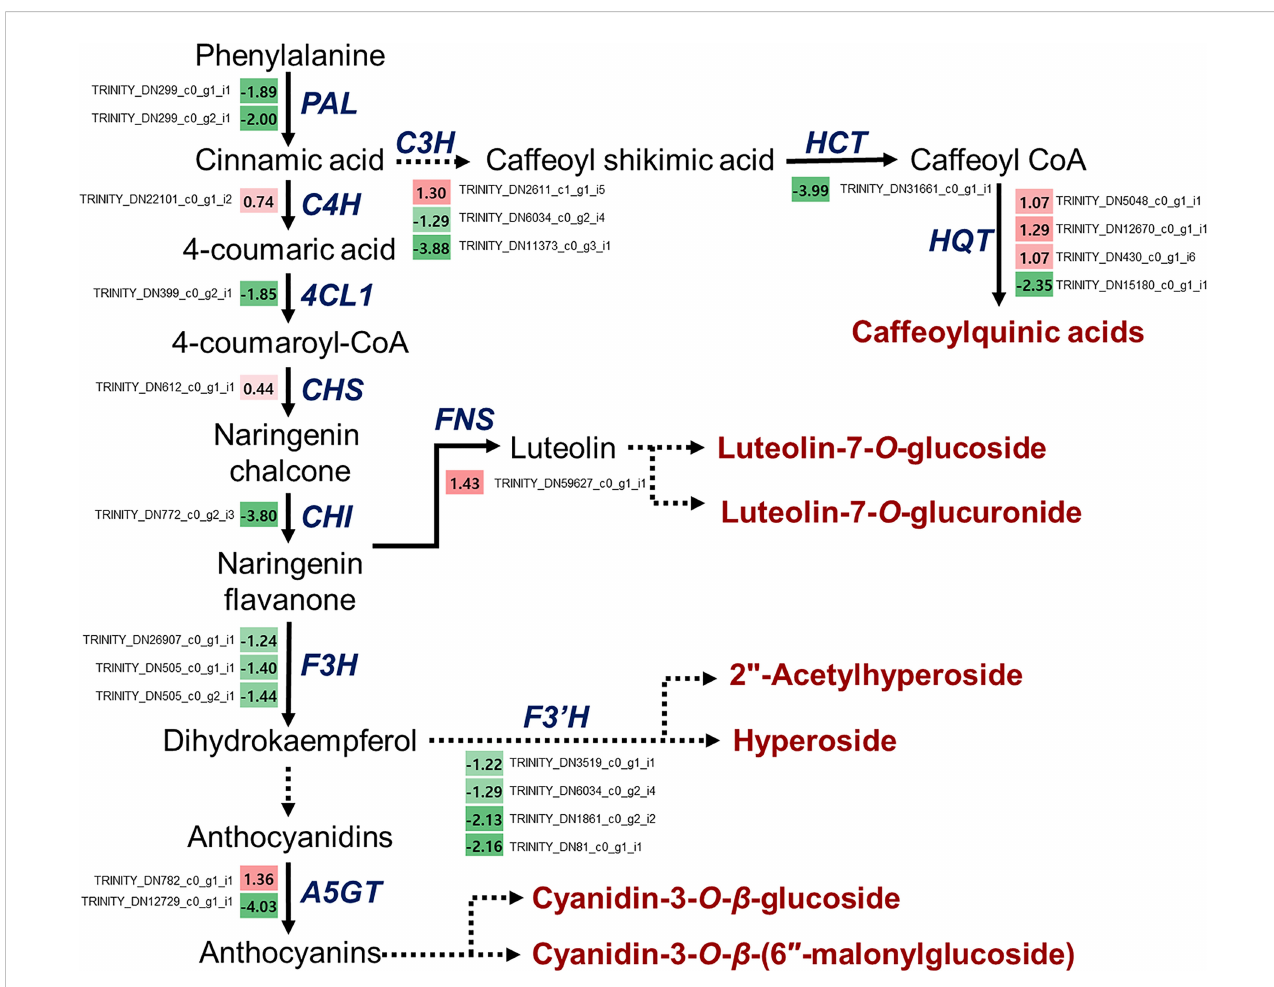
FIGURE 4 Drought-responsive genes in the phenylpropanoid biosynthesis from L. fi scheri . A color gradient from low (green) to high (red) represents the relative levels of expression. The numbers in the squares indicate FC in gene expression in drought-induced L. fi scheri plants, compared to